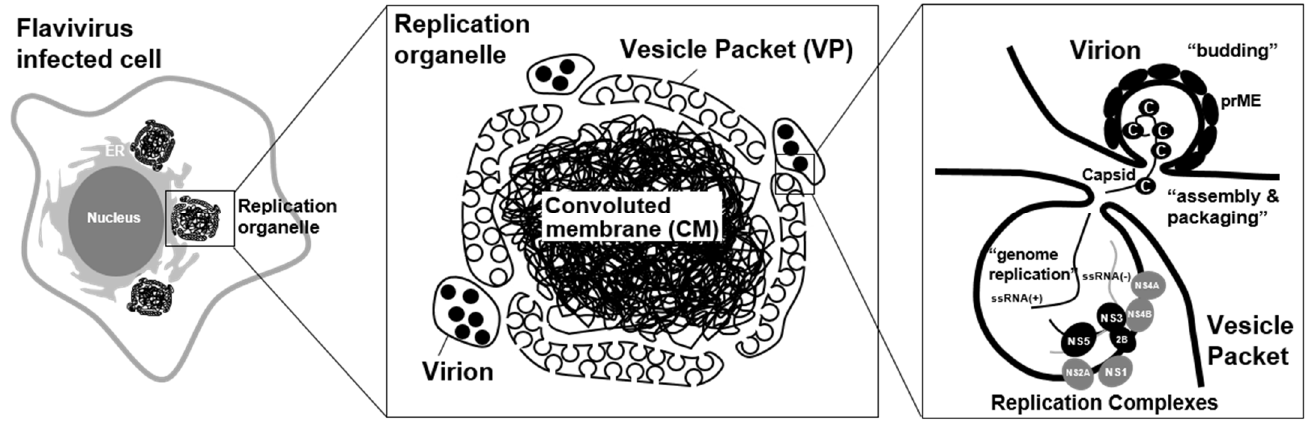
Figure 1. Flavivirus replication organelle. Virus antigen-positive structure was observed in flavivirus infected cells. These structures, called viral replication organelle, are composed of two distinct compartments: a vesicle packet (VP) and a convoluted membrane (CM). VP contains a few dozen small membrane vesicles, and the inner areas of these vesicles are connected to the cytosol through small pores. VPs have been considered to be the location of viral genome replication. The progeny positive-sense RNAs are synthesized in the VP vesicles by the viral replication complexes. The newly synthesized genomic RNAs are exported to the outside of the vesicles to be assembled into infectious particles at a proximal area of the vesicle pore [28]. A CM is forming a reticulovesicular network of membranes. Since it contains abundant viral non-structural membrane proteins, the role of the CM was previously proposed to be as the location for the processing or storage of viral polyproteins